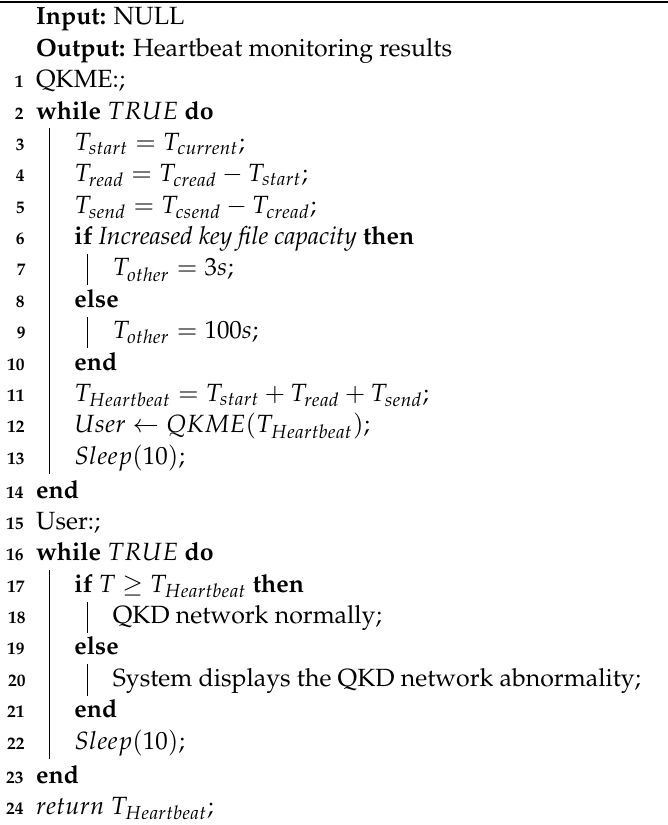
Algorithm 3: Real-time monitoring